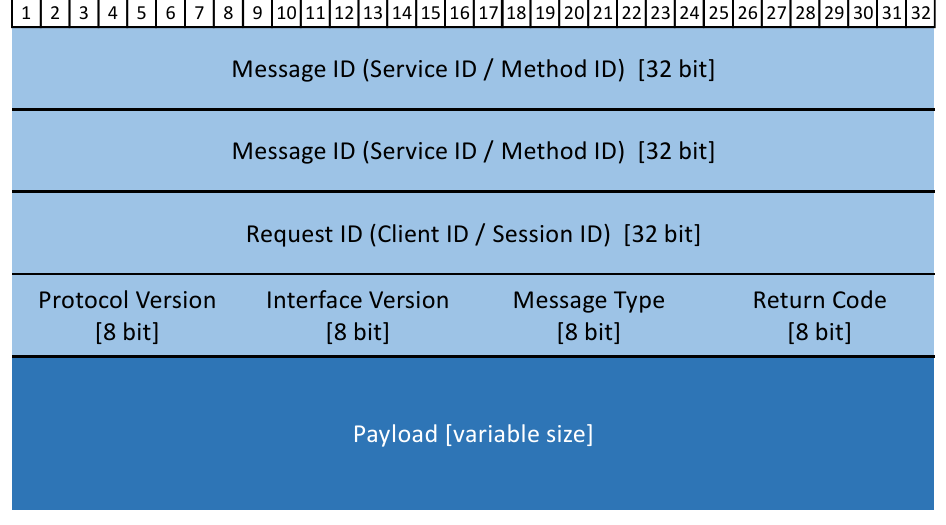
Figure 3. Automotive Ethernet and its upper-layer protocol architecture.